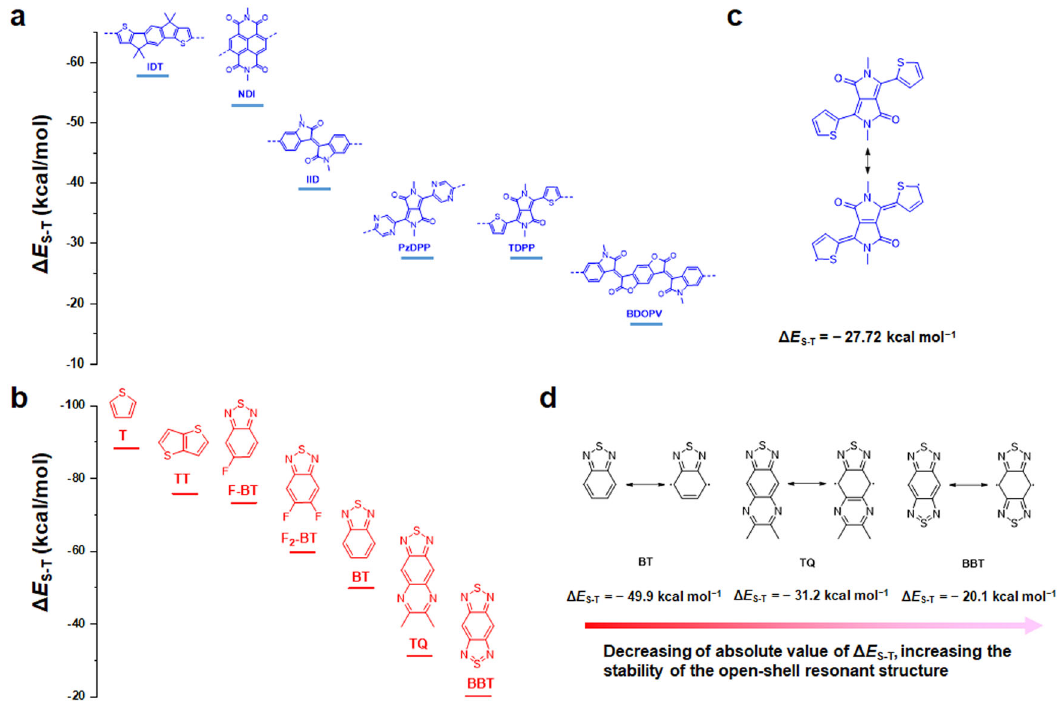
Fig. 2 Computer-aided polymer building block screening approach to the rational design of high-spin ground-state semiconducting polymers. DFT Calculated Δ E S-T values of a “ large fused aromatic ” and b “ small-size aromatic ” building blocks used in high-mobility semiconducting polymers; c The closed-shell and open-shell resonance structures of TDPP. d The closed-shell and open-shell resonance structures of BT, TQ, and